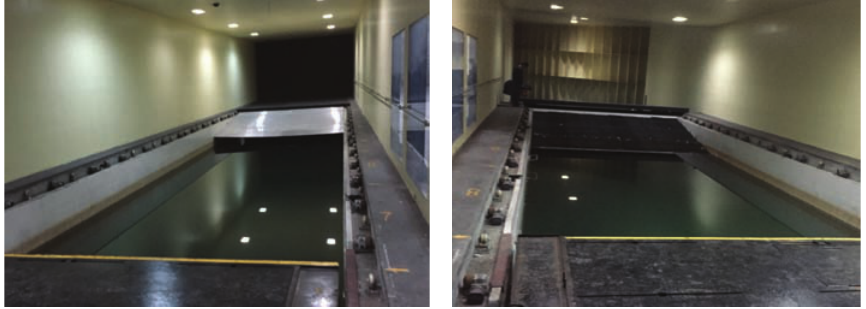
Figure 3: A deep